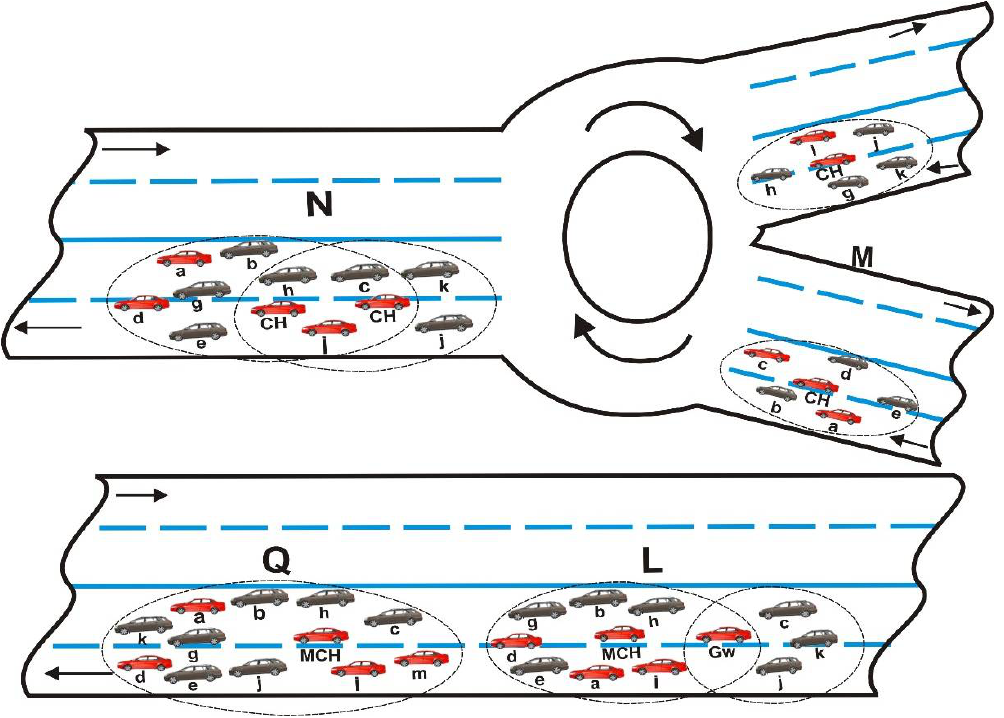
Figure 3. Illustrations of cluster merging phases (from M –> N –> L –>